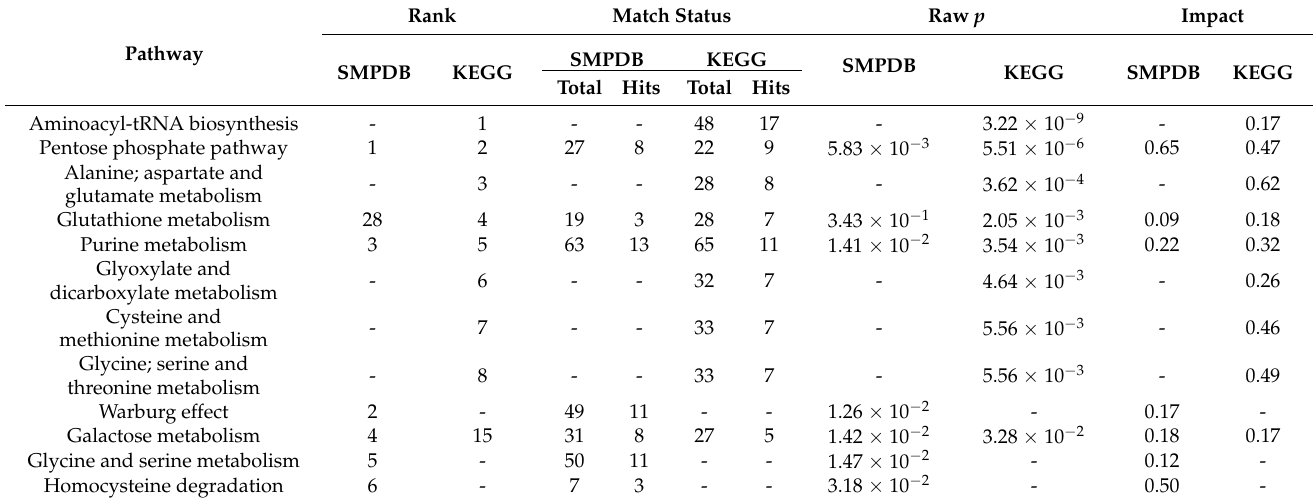
Table 1. Ranking of the top pathway analysis results (against SMPDB and KEGG databases). The “Rank” column reflects the degree of significance of the identified pathway against both